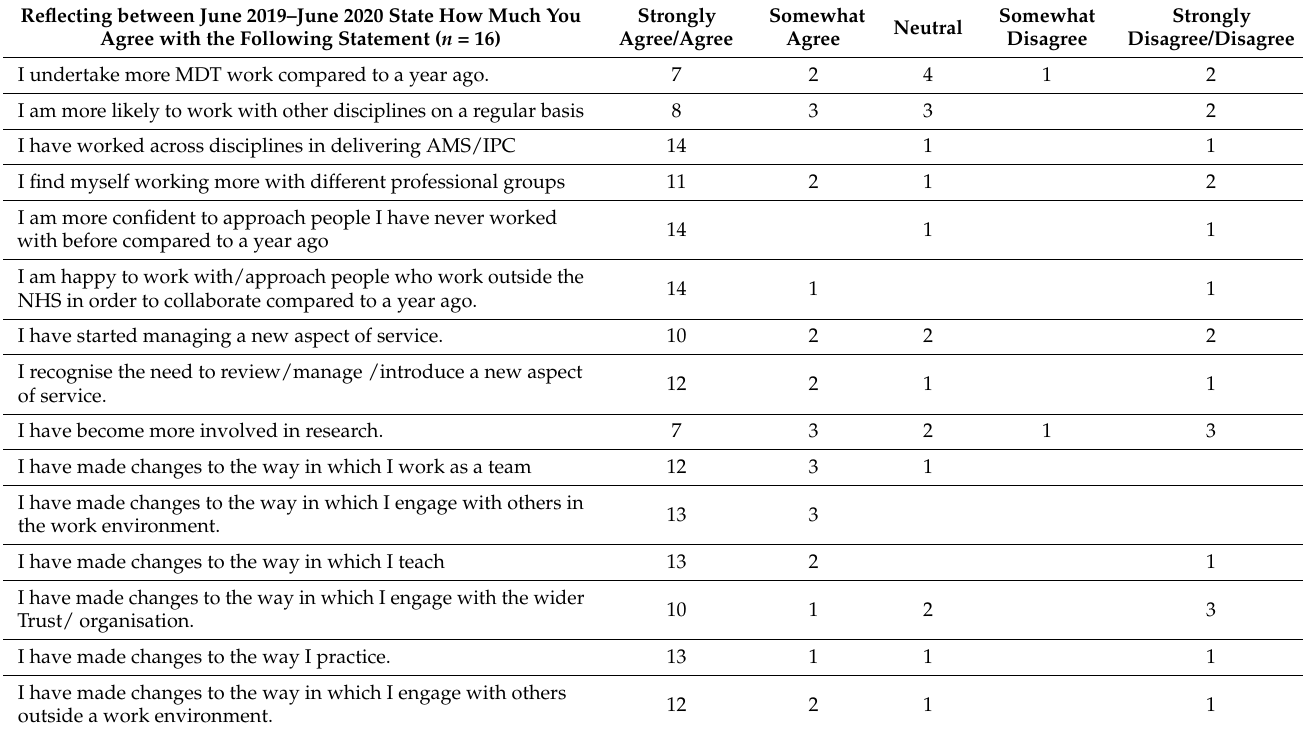
Table 4. Reflective statements for professional activities and skills undertaken and developed over the CPhOGH Fellowship year. Reflecting between June 2019–June 2020 State How Much You Agree with the Following Statement ( n =